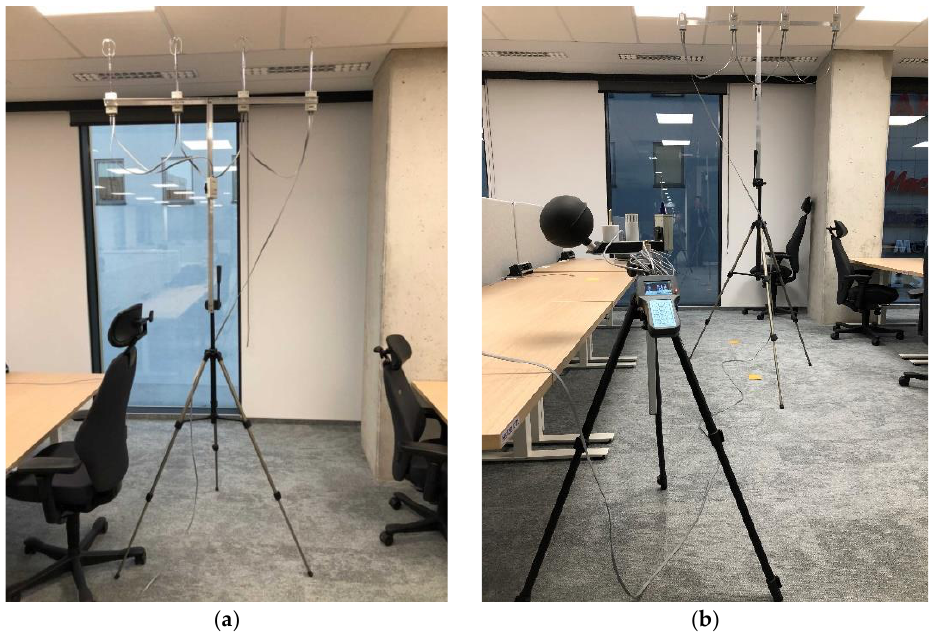
Figure 4. View of measuring probes in open space office in building: ( a ) velocity transmitters; ( b ) microclimate meter.